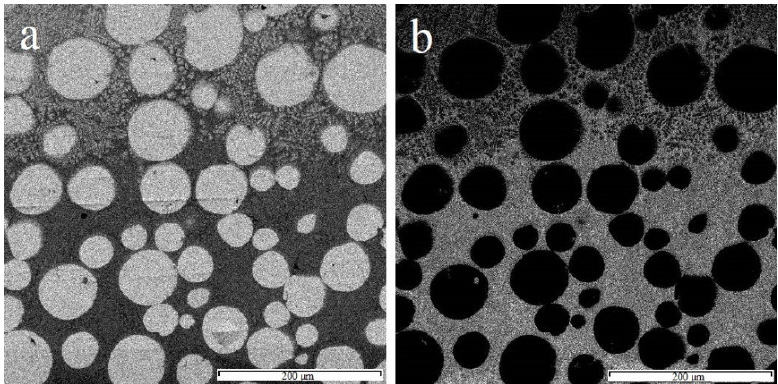
Figure 12. EDX distribution maps of ( a ) Mo and ( b ) Fe on the Mo–steel boundary.